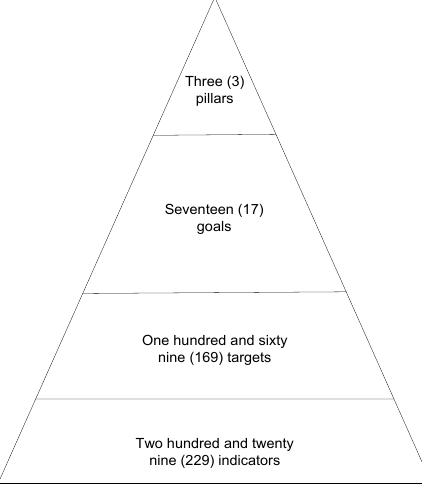
Figure 1. SDG measurement pyramid.